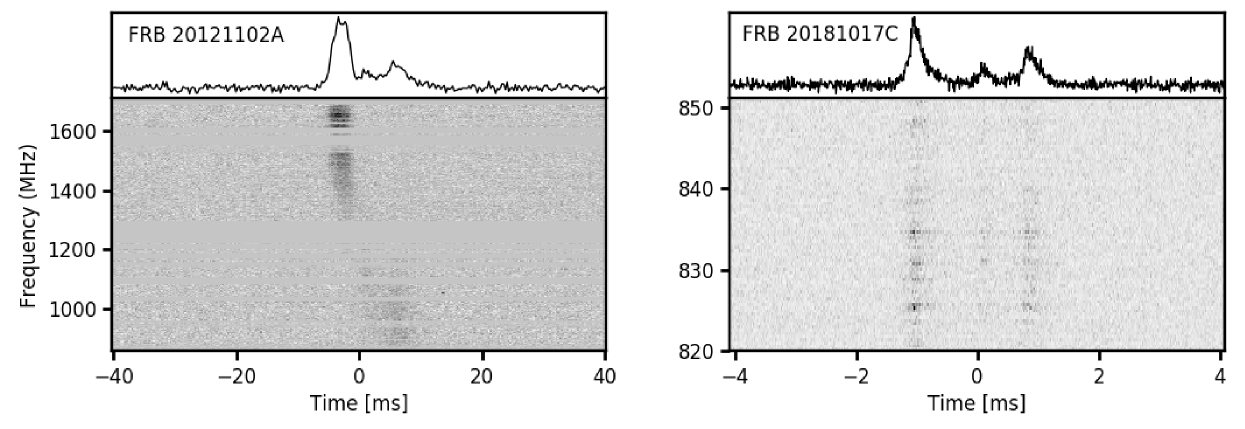
Figure 5. Dynamic spectra of FRBs 20121102A and 20181017C detected at the MeerKAT and UTMOST telescopes respectively. The top panel in each pulse shows the frequency-averaged pulse profile. The data are uncalibrated, and the flux densities are in arbitrary units. Left panel : The single pulse from FRB 20121102A has been dedispersed to the structure maximising DM which reveals downward frequency drifting in three distinct features. The data have a time resolution of 306.24 µ s. Right panel : The single three-peaked pulse from FRB 20181017C has a time resolution of 10 µ s as voltage data was recorded. The three peaks have consistent scattering timescales and pulse widths and show frequency striations of a few 100 kHz due to